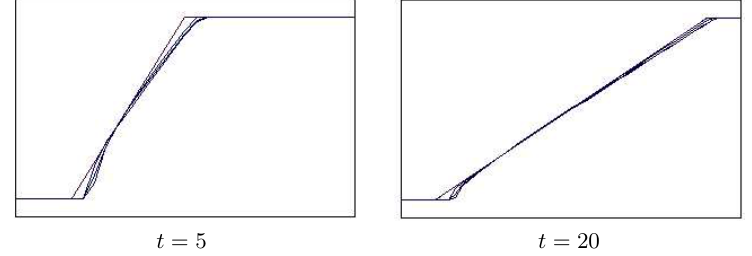
Figure 15. Numerical solution for the Babenko scheme for 4 initial data ( (cid:13) = 0 : 1; 0 : 5; 0 : 9 ).